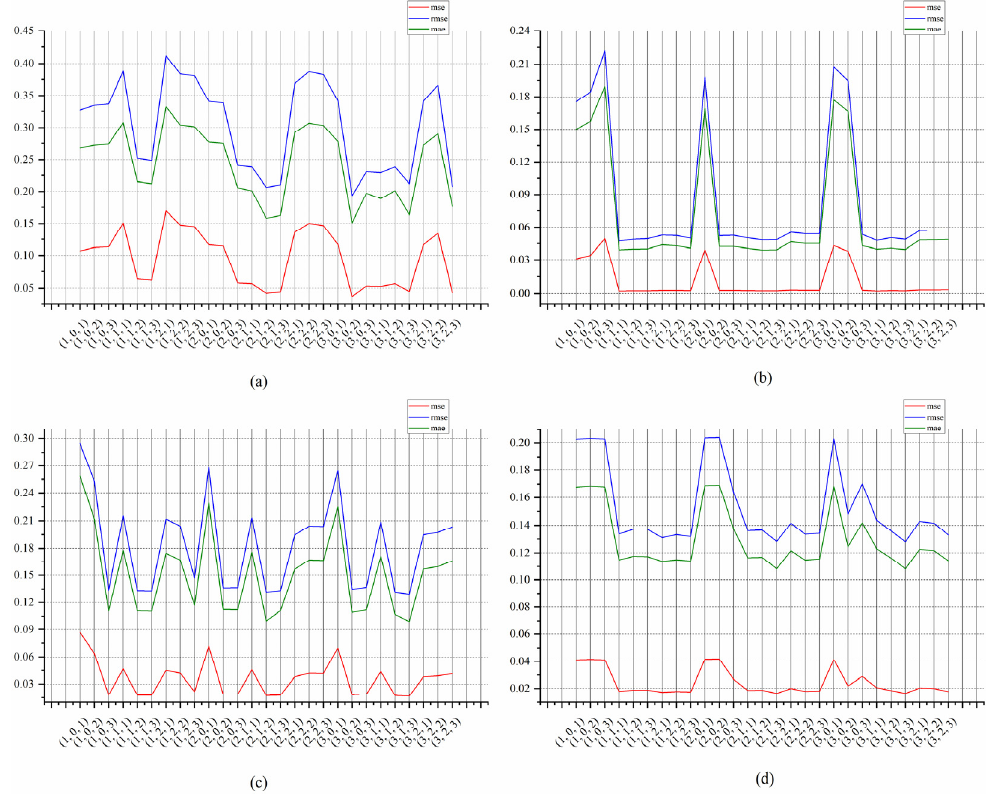
Figure 10. Prediction performance analysis of different parameters selected using ARMA in different periods. Based on the temperature data of (0, 960), (960, 1920), (1920, 2880), (2880, 3840) periods, ARMA models with different (p, d, q) parameters are used to predict the temperature data of the next 24 h period; calculate the MAE, MSE and RMSE formed by the predicted values and the original monitoring values; and draw the analysis curves ( a – d ).